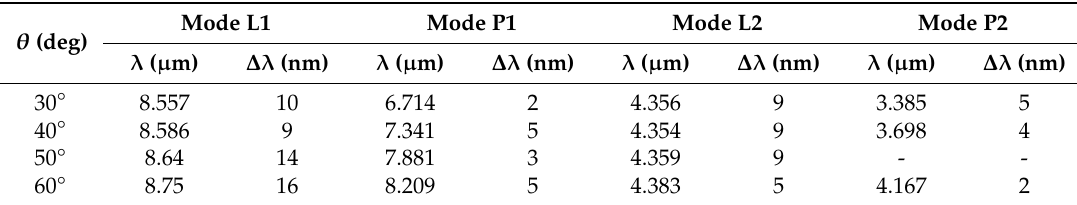
Figure 4. (a) Measured and ( b ) simulated wavelength shifts of both local surface plasmon resonances (LSPRs) and propagating surface plasmon resonances (PSPs) in the metagrating sample. Table 2. Measured wavelength shift values of local surface plasmon resonances (LSPRs) and propagating surface plasmon resonances (PSPs) in the metagrating sample.